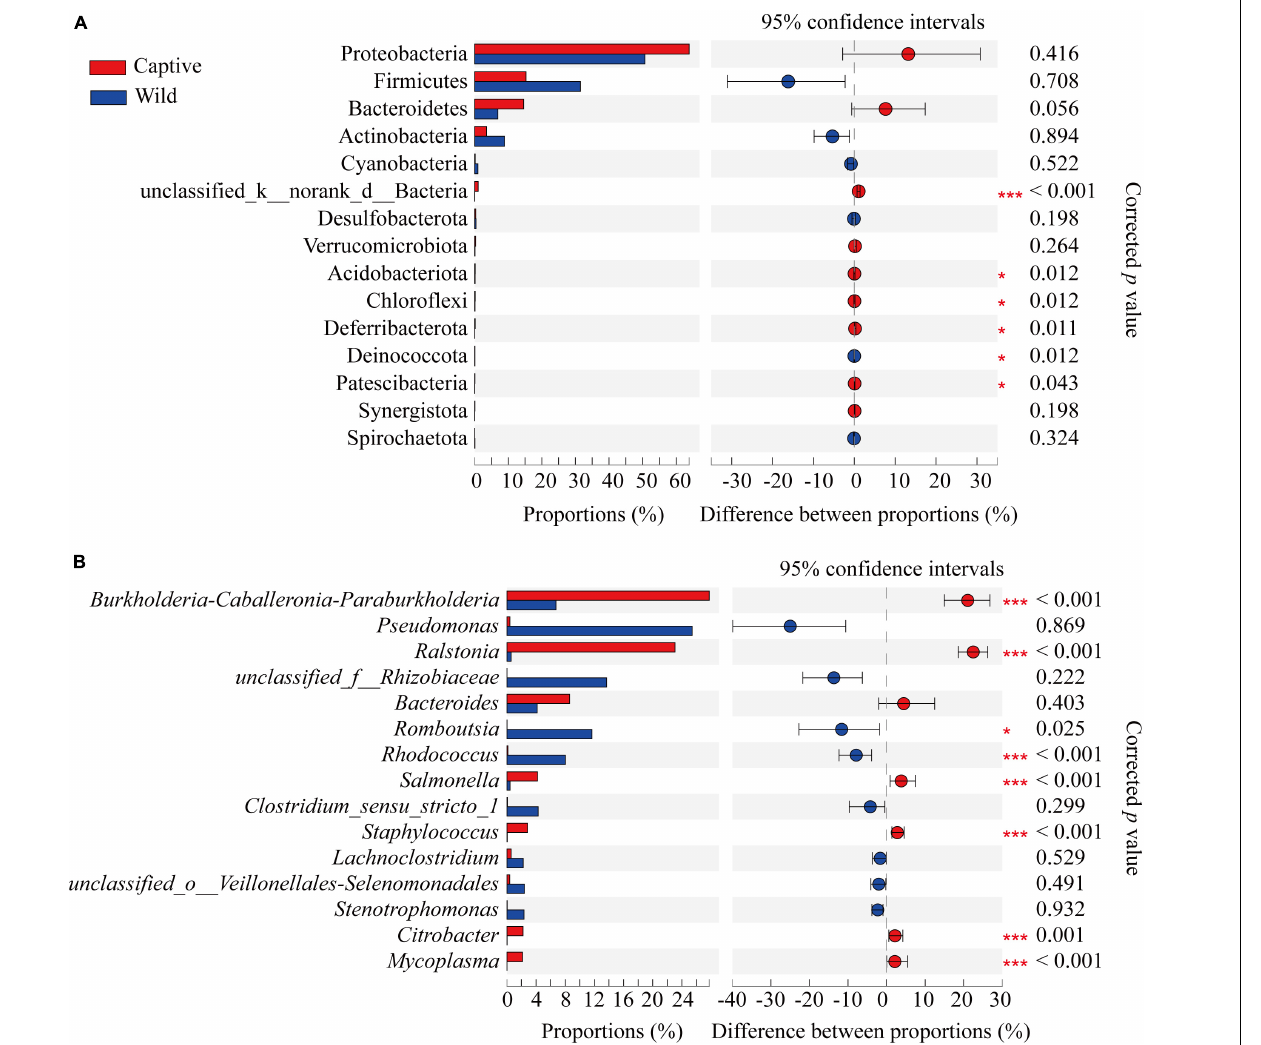
FIGURE 5 | Differences in gut microbiota composition between captive and wild geckos at the phylum level (A) and genus level (B) of the top 15 taxa. Significant difference 0.01 < p ≤ 0.05 was marked as “*”, and p ≤ 0.001 was marked as